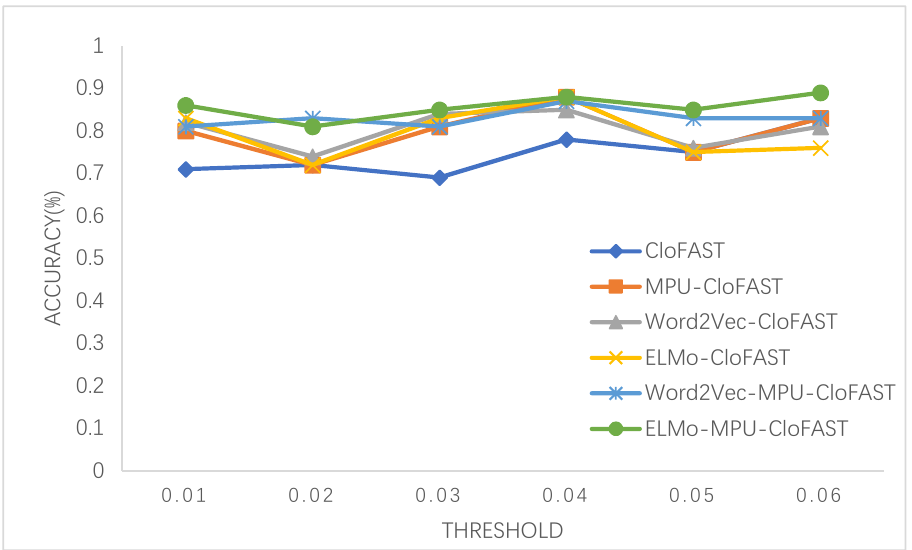
Figure 9. Accuracy comparison of different algorithms.